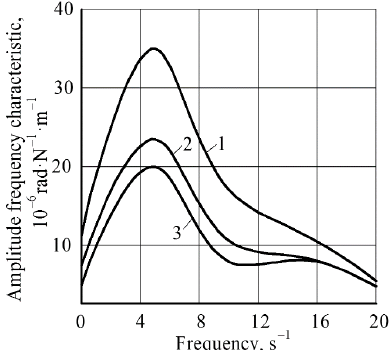
Figure 5. The amplitude–frequency characteristic of angle β during the processing of the disturbing impact by the technological module at different speeds of movement of the machine-and-tractor aggregate of a modular type ( V o ): 1—1 m ∙ s − 1 ; 2—2 m ∙ s − 1 ; 3—3 m ∙ s − 1 .